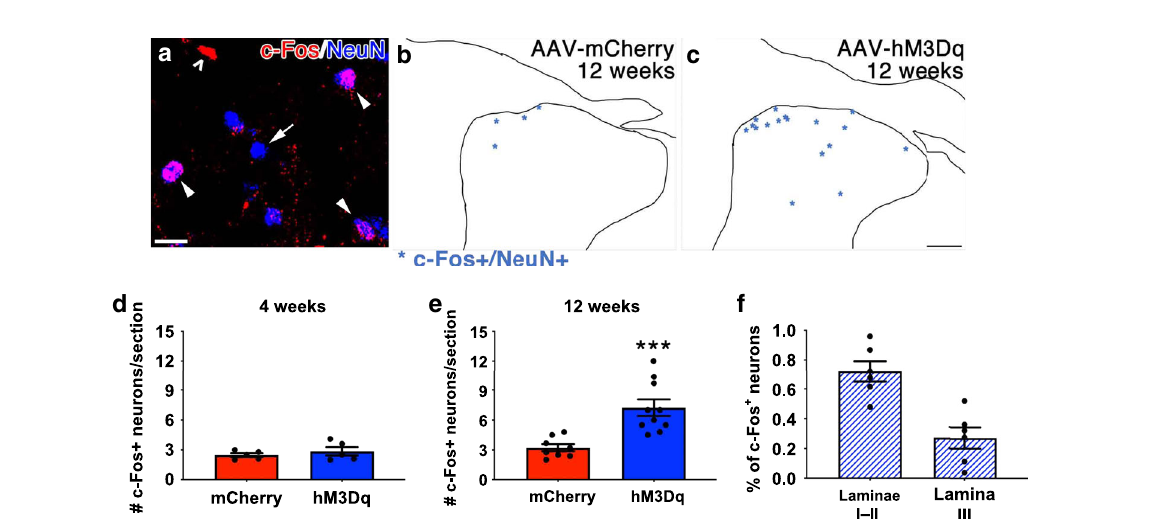
Fig. 7 Axons that regenerate into spinal gray matter upon chronic, CNO-induced chemogenetic neuron form functional synapses. Four weeks and 12 weeks after complete C4-T1 dorsal root crush injuries, ipsilateral median and ulnar nerves were isolated and electrically stimulated for 30 min. Animals were sacri fi ced 1 hr later. Spinal cord sections between C5 and C8 were processed for immunohistochemistry to visualize c-Fos (red) and NeuN (blue), shown in a . Not all NeuN + nuclei were also c-Fos + ( a , arrow) and not all c-Fos + nuclei were in NeuN + neurons ( a , open arrowhead). Only c-Fos + /NeuN + nuclei ( a , closed arrowheads) were noted and counted. C-Fos + /NeuN + nuclei in tracings of representative sections from mCherry- or hM3Dq-injected animals 12 weeks after crush are shown as asterisks in panels b and c . Four weeks after injury, electrical stimulation of the median and ulnar nerves induced c-Fos expression in few neurons within ipsilateral gray matter ( d ). There is no statistical difference between groups. At 12 weeks post-injury, more c-Fos + neurons were observed in gray matter in animals that received repeated, daily activation of hM3Dq + DRGs ( e ). The majority of these c-Fos + neurons were located in more super fi cial laminae I and II (72.1 ± 0.7%). However, an appreciable percentage (27.3 ± 0.7%) was present in lamina III ( f ). N = 5 animals per group at 4 weeks; N = 8 mCherry + animals and 10 hM3Dq + animals at 12 weeks. Mean ± SEM. Two-tailed unpaired t -test, *** p = 0.0008. Scale bars: